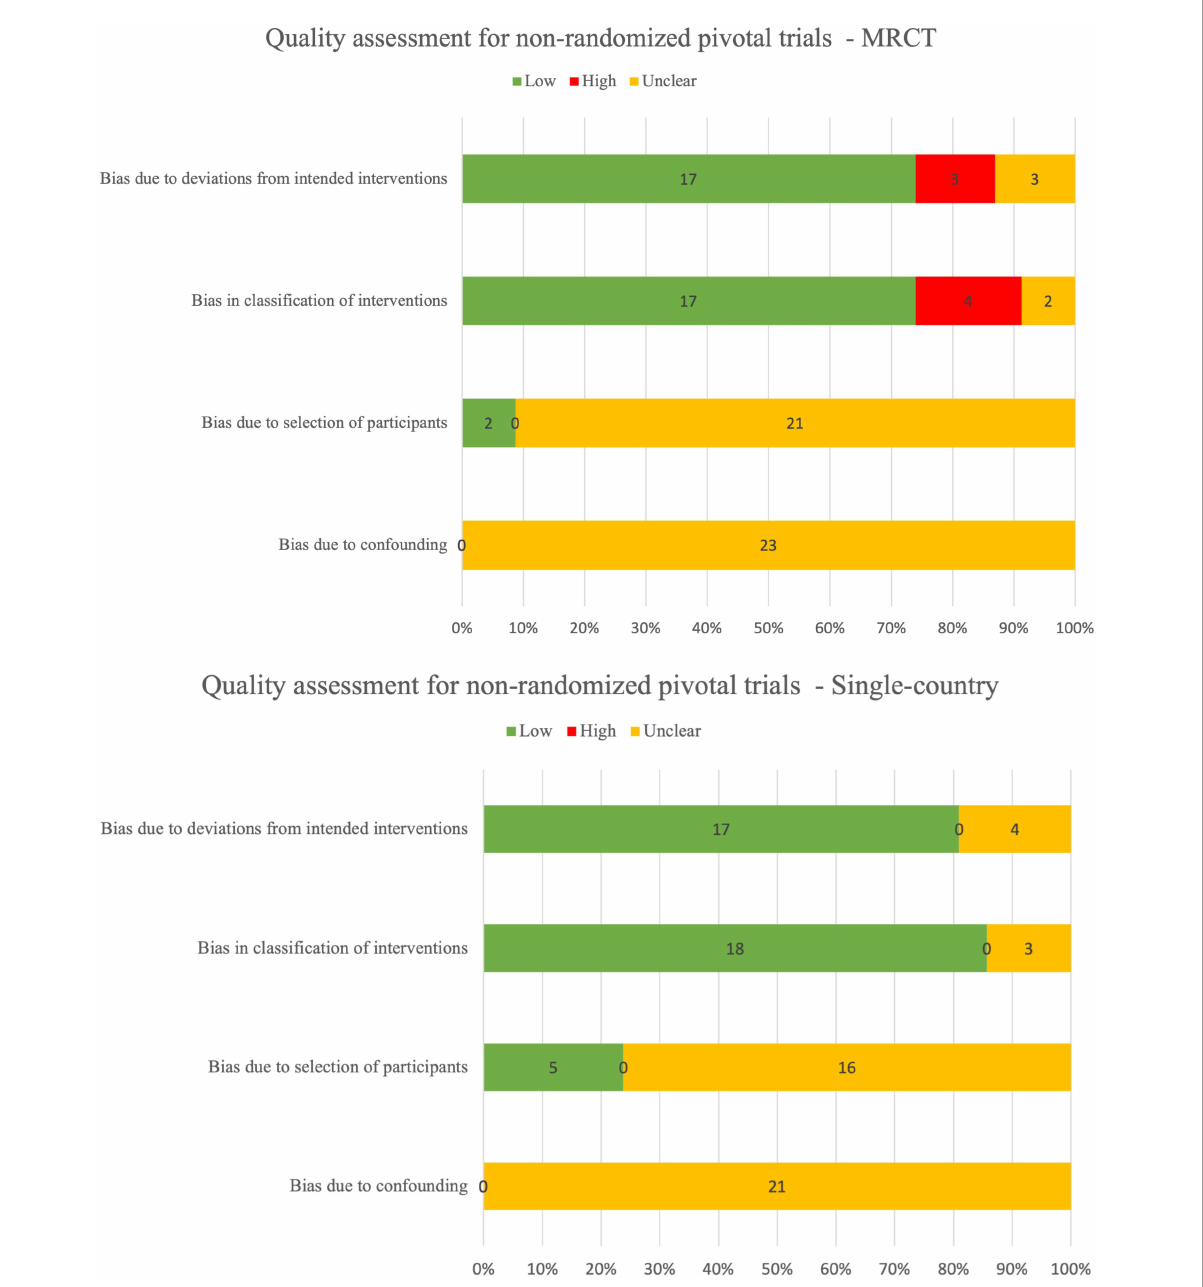
FIGURE3 Quality assessment for non-randomized pivotal trials using ROBINS-I.